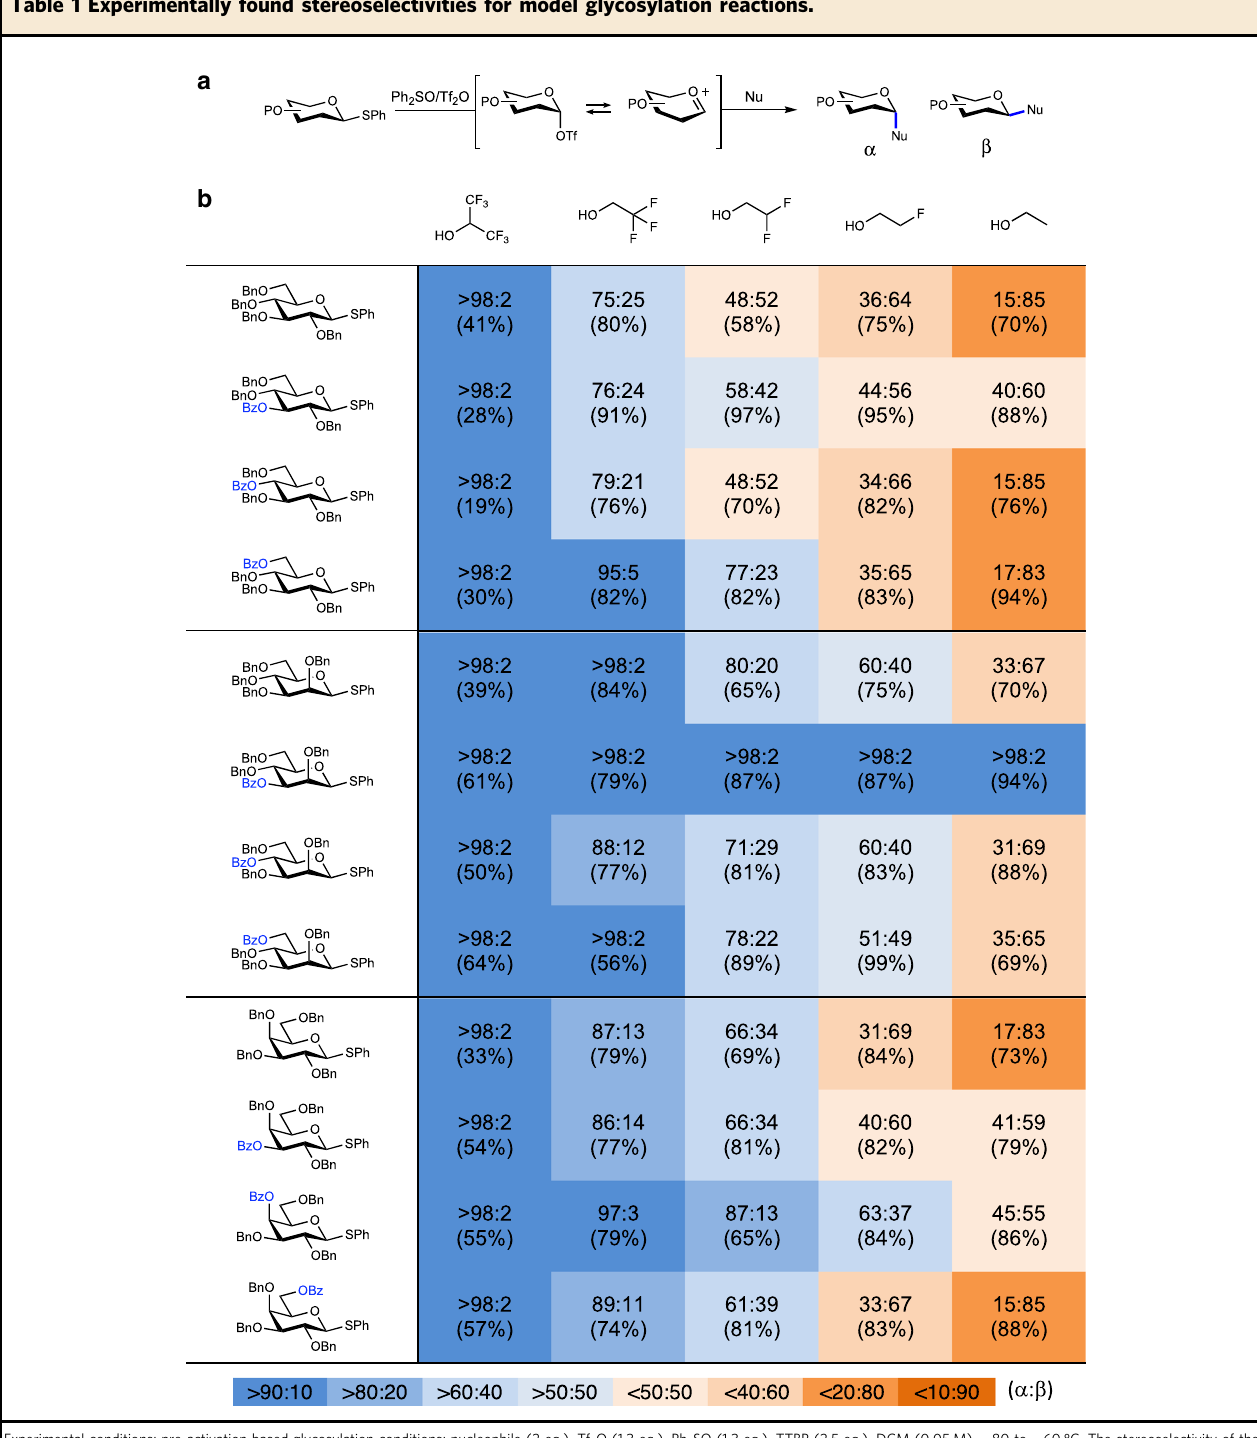
Table 1 Experimentally found stereoselectivities for model glycosylation